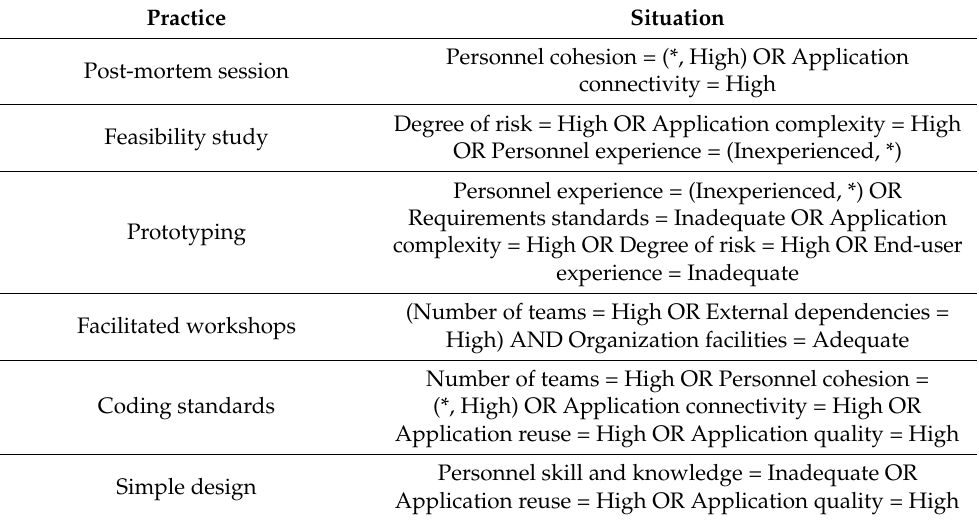
Table A2. Process elements defined in PIMB.